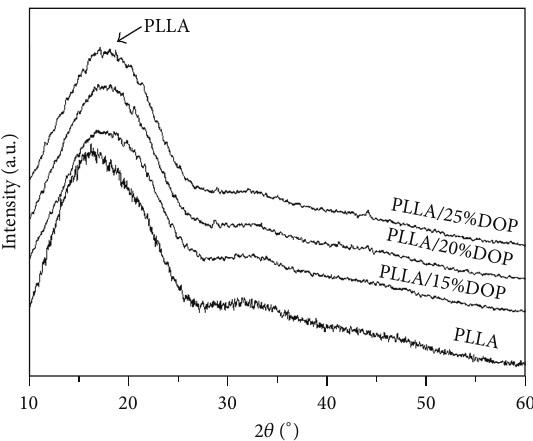
Figure 3: XRD curves of PLLA and PLLA/DOP samples for 4min at 85 ∘ C.